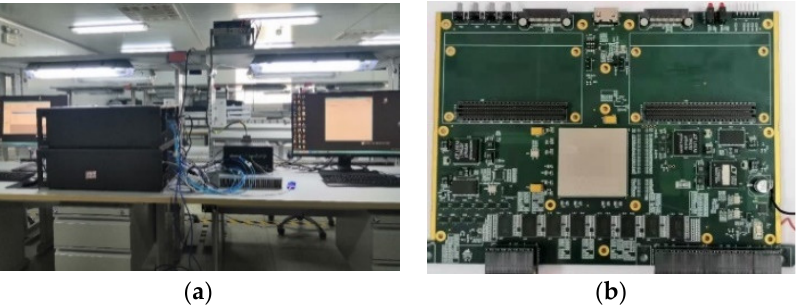
Figure 8. Experimental environment and platform. ( a ) Ground verification system; ( b ) Experiment platform.